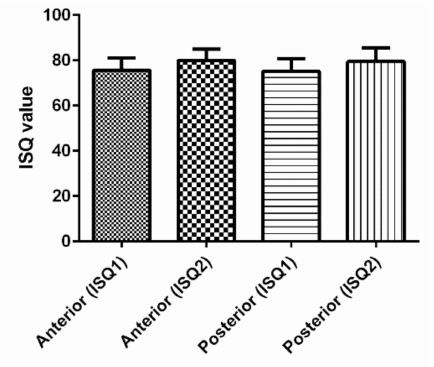
Figure 3. ISQ 1 and 2 values distribution within different implant lengths (9, 11 and 13 mm).